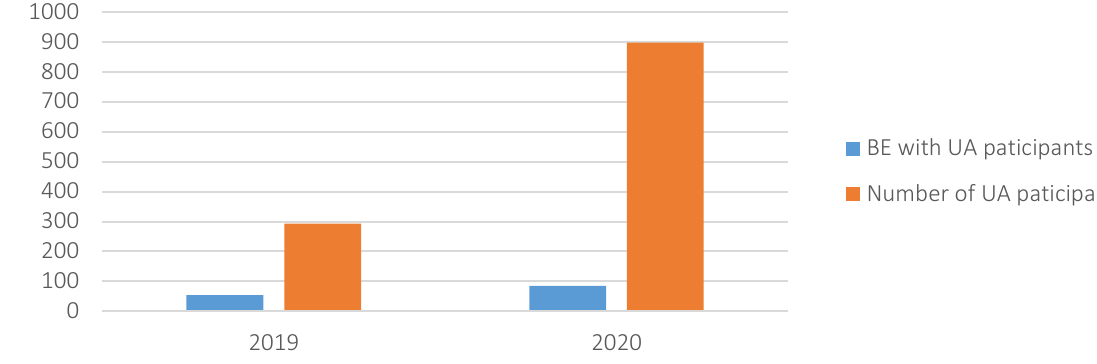
Figure 10. Comparative diagram of the total number of brokerage events in which Ukrainians took